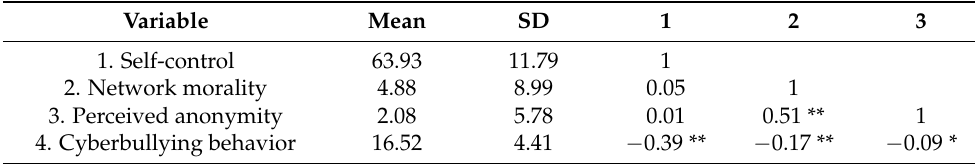
Table 2. Correlation analysis of all continuous